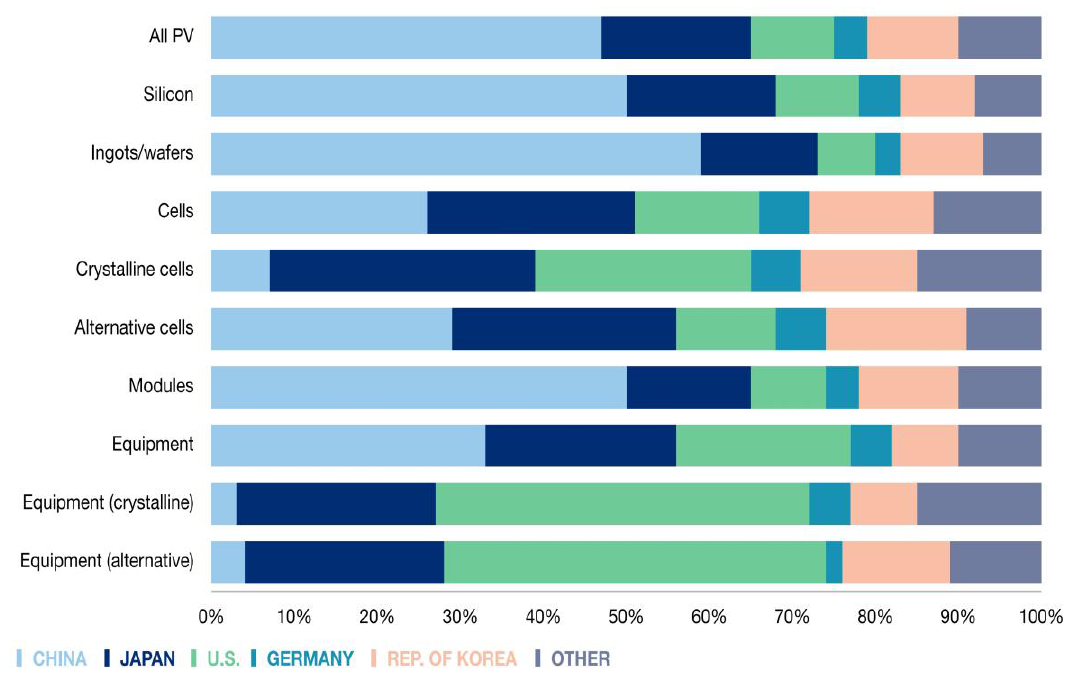
Figure 2. Percentage distribution of PV-related patents by origin and value chain segment. (Repro- duced with permission from [World Intellectual Property Report 2017], World Intellectual Property Organization, 2017 [4]).